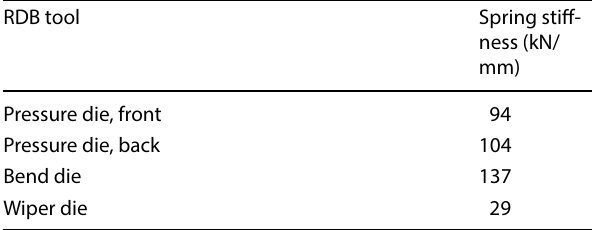
Table 3 Axis shifting of the RDB tools (linear